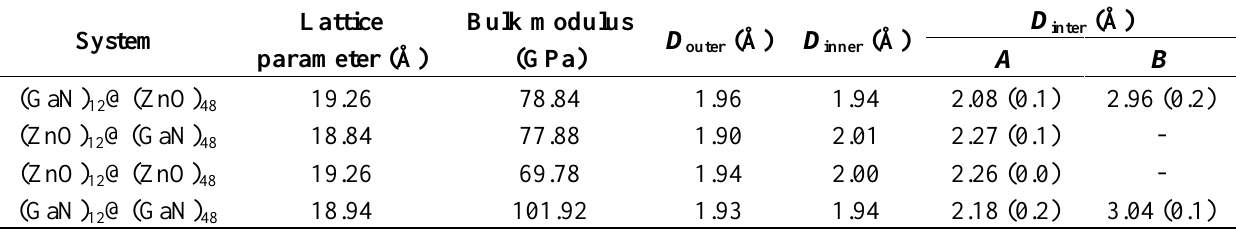
Table 4. Structural parameters of double bubble frameworks. (Number in parentheses indicates standard error).